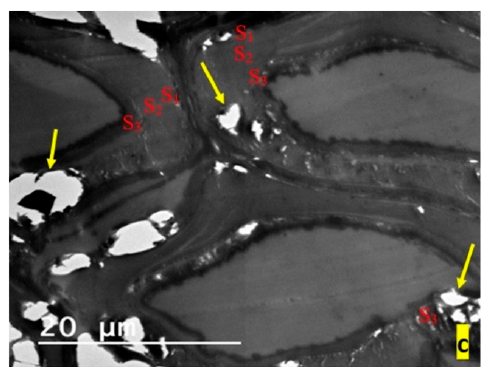
Figure 3. TEM photos of wood samples infected with A. flavus, showing soft-rot decay type II (erosion), starting from the S 2 layer and extending to the S 1 layer. Increasing the electron-lucent appearance of some regions in middle lamella and secondary wall layers suggests a loss of wood substance ( a , c ). In addition, checks (CH) and splits are frequently noted within the secondary cell wall regions ( b ).